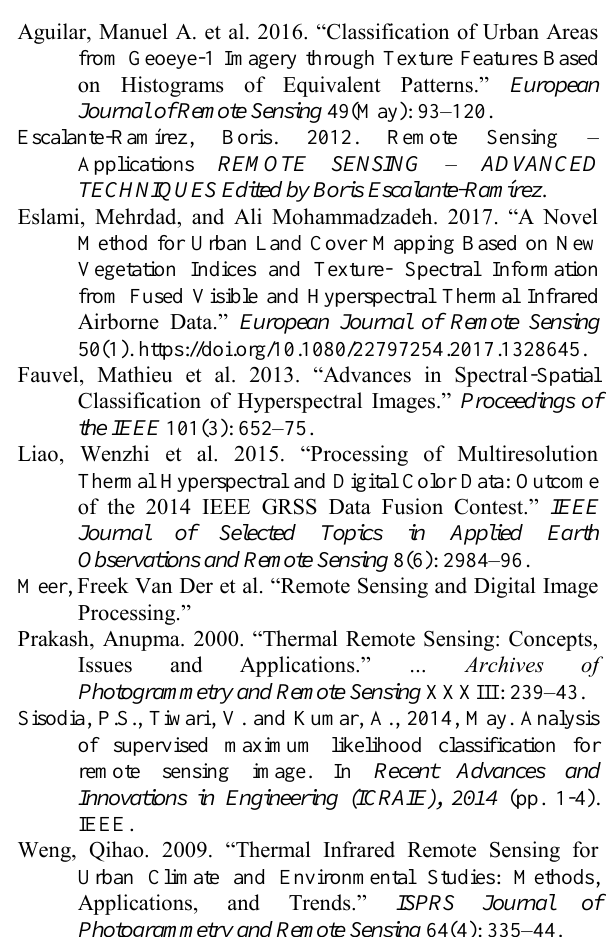
Figure 7. The sharpness of the 1-meter (b) and 4-meter (b) TIR